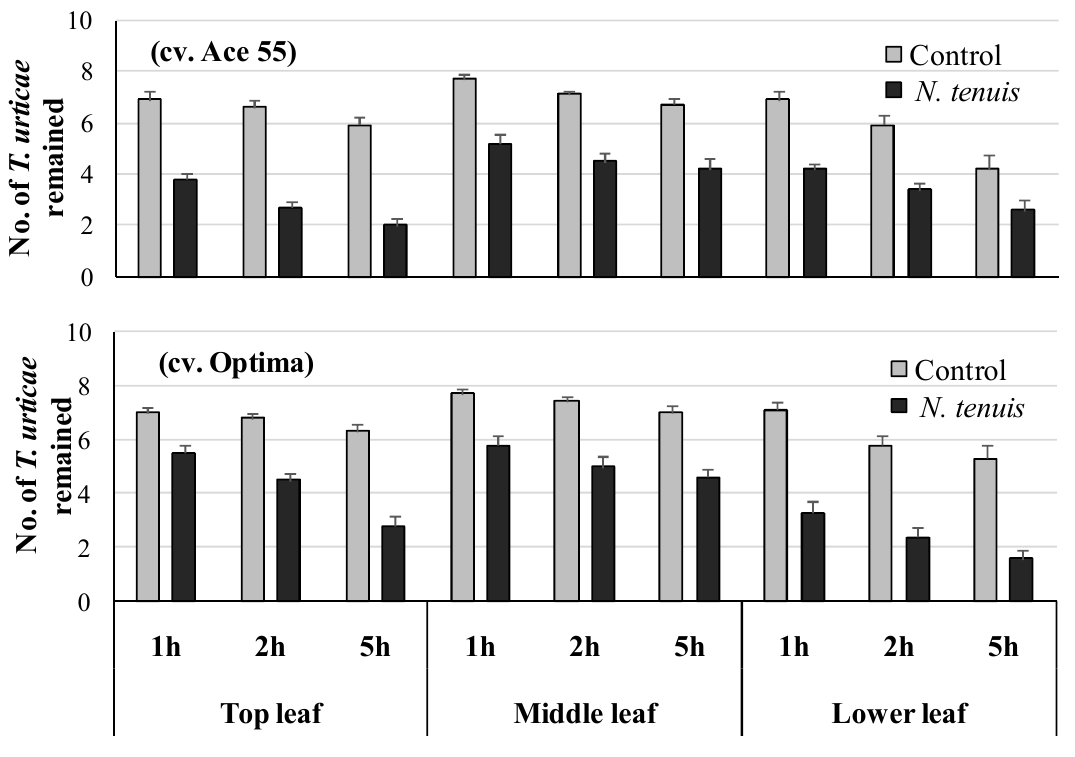
Figure 2. Number of T. urticae adults (mean ± SE) remained on leaflets of top, middle, or lower leaves of tomato plants punctured by N. tenuis in comparison to unpunctured plants of two tomato cultivars after 1, 2, and 5 h for cv. Ace 55 and cv. Optima. In all cases, a significantly higher number remained on the control than the treated leaf in each time interval in both cultivars. A significantly higher number of adults remained 1 h than at 2 h and 5 h post treatment on the control leaf, in the case of cv. Optima.